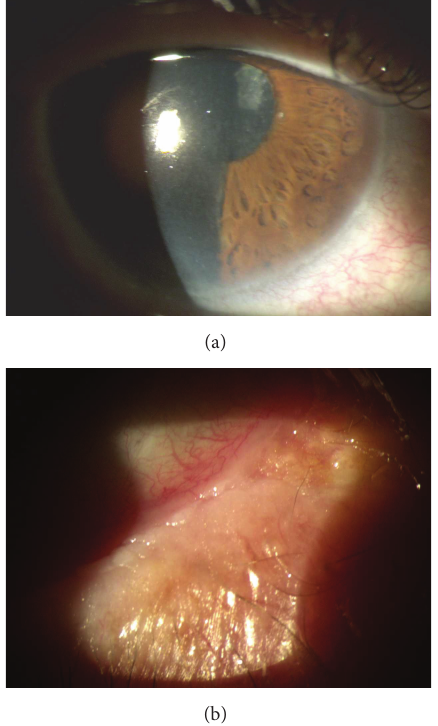
Figure 7: Right eye before therapy.